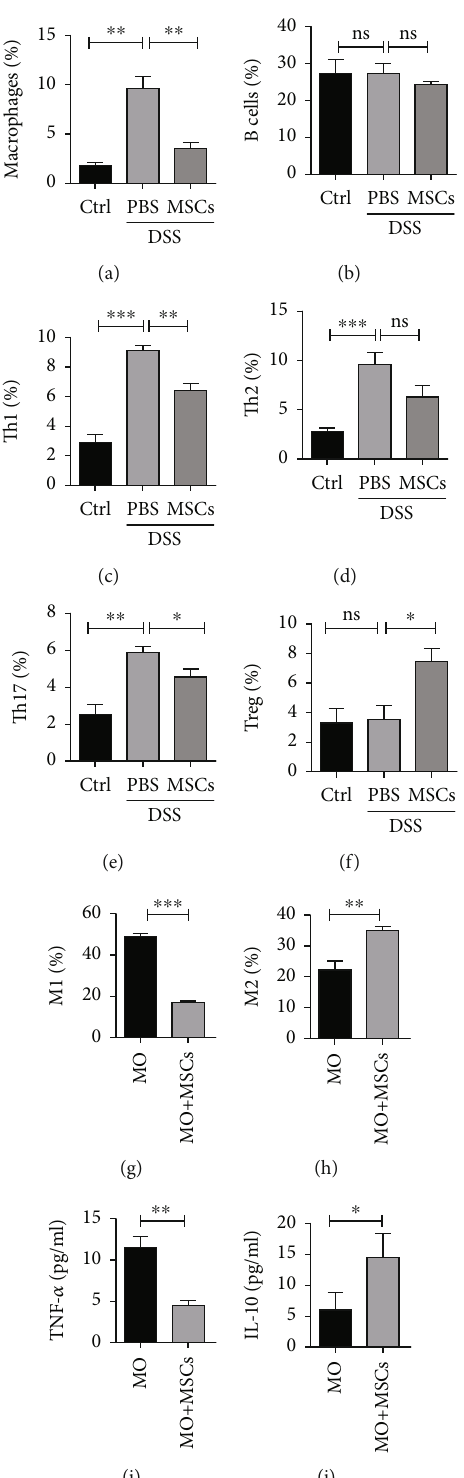
Figure 6: HUC-MSCs regulate immune cell balance. (a) Transplant of HUC-MSCs downregulated activated macrophage in the colon mucosa. With the treatment with DSS, the activated macrophages in the colon mucosa were signi fi cantly increased, whereas therapy with HUC-MSCs, the percentage of activated macrophages was decreased greatly. (b) HUC-MSCs have no signi fi cant e ff ect on the proportion of B cells in DSS-induced colitis mice. (c, d) Transplant of HUC-MSCs decreased Th1 and Th2 in DSS-induced colitis mice. (e, f) Transplant of HUC-MSCs decreased Th17 while increased Treg in DSS-induced colitis mice. (g – j) The in fl uence of HUC-MSCs on di ff erentiation and secretion of macrophages. Error bars: mean ± SD . ∗ p < 0 : 05 ; ∗∗ p < 0 : 01 ; ∗∗∗ p < 0 : 005